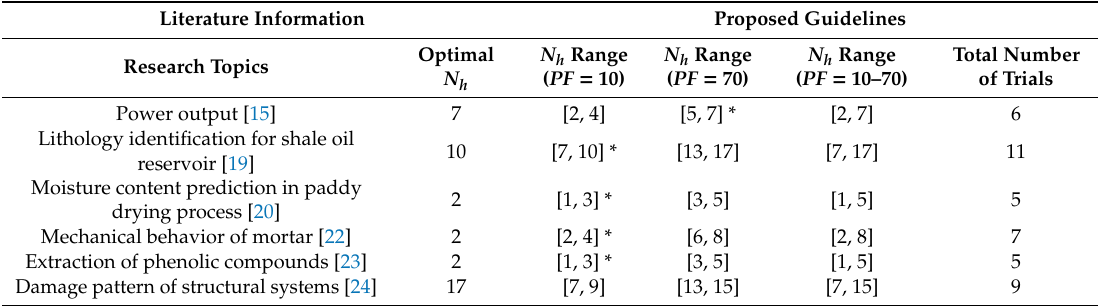
Figure 4. The relation between PF and A (a function of PF ). Table 6. Comparison of optimal node numbers in literature and the predicted ranges from the proposed